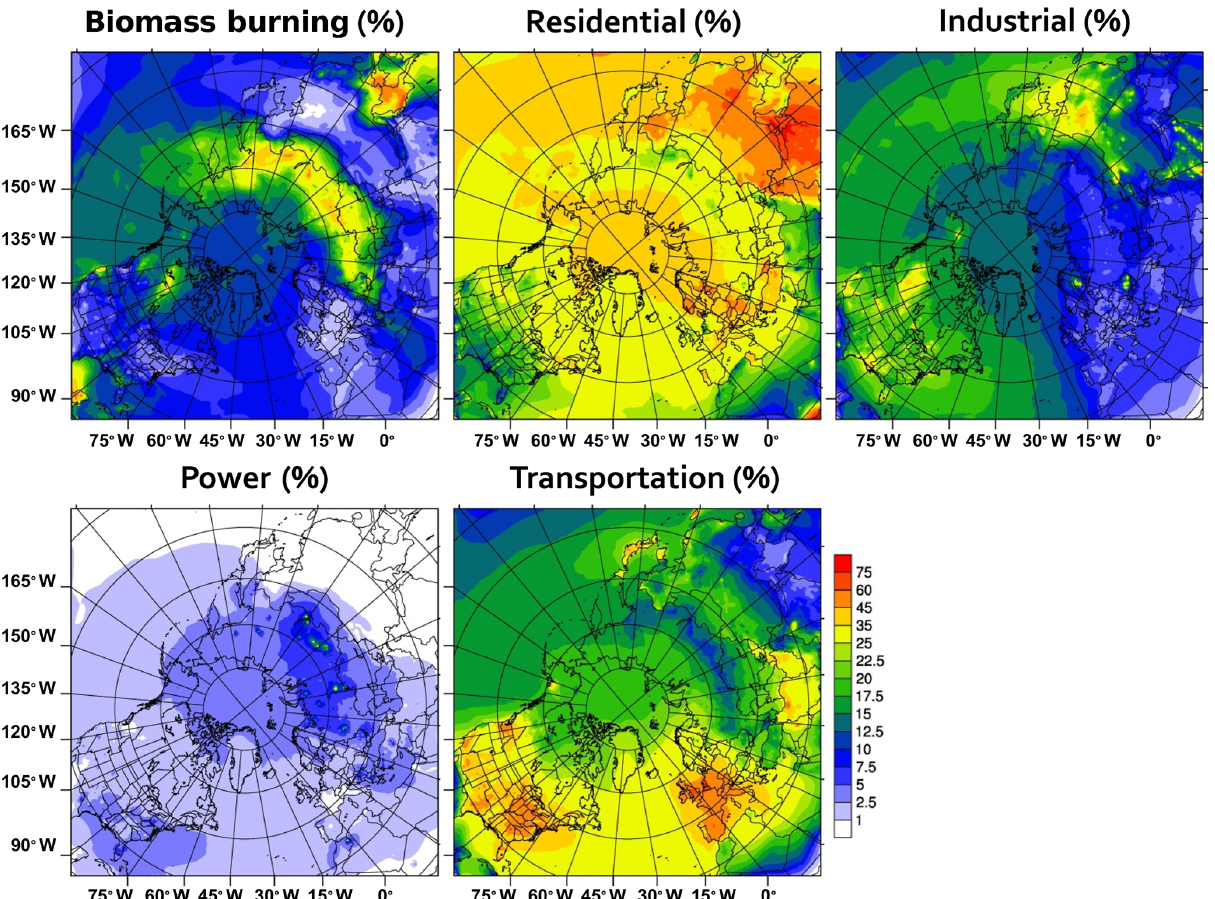
Figure 9. Spatial distribution of source sector contributions (%) to annual BC surface concentration over the entire domain. This figure is generated using NCAR Command Language (NCL) version 6.3.0, open-source software free to the public, by UCAR/NCAR/CISL/TDD, http://dx.doi.org/10.5065/D6WD3XH5 (last access: 13 November